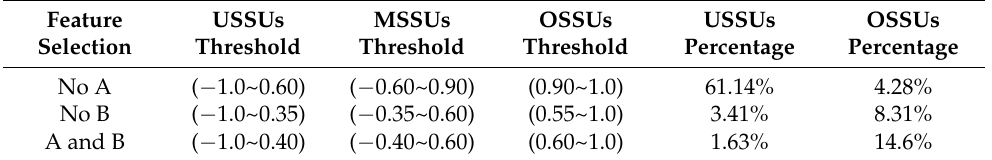
Table 3. Classification threshold and corresponding proportion of MSSUs, USSUs and